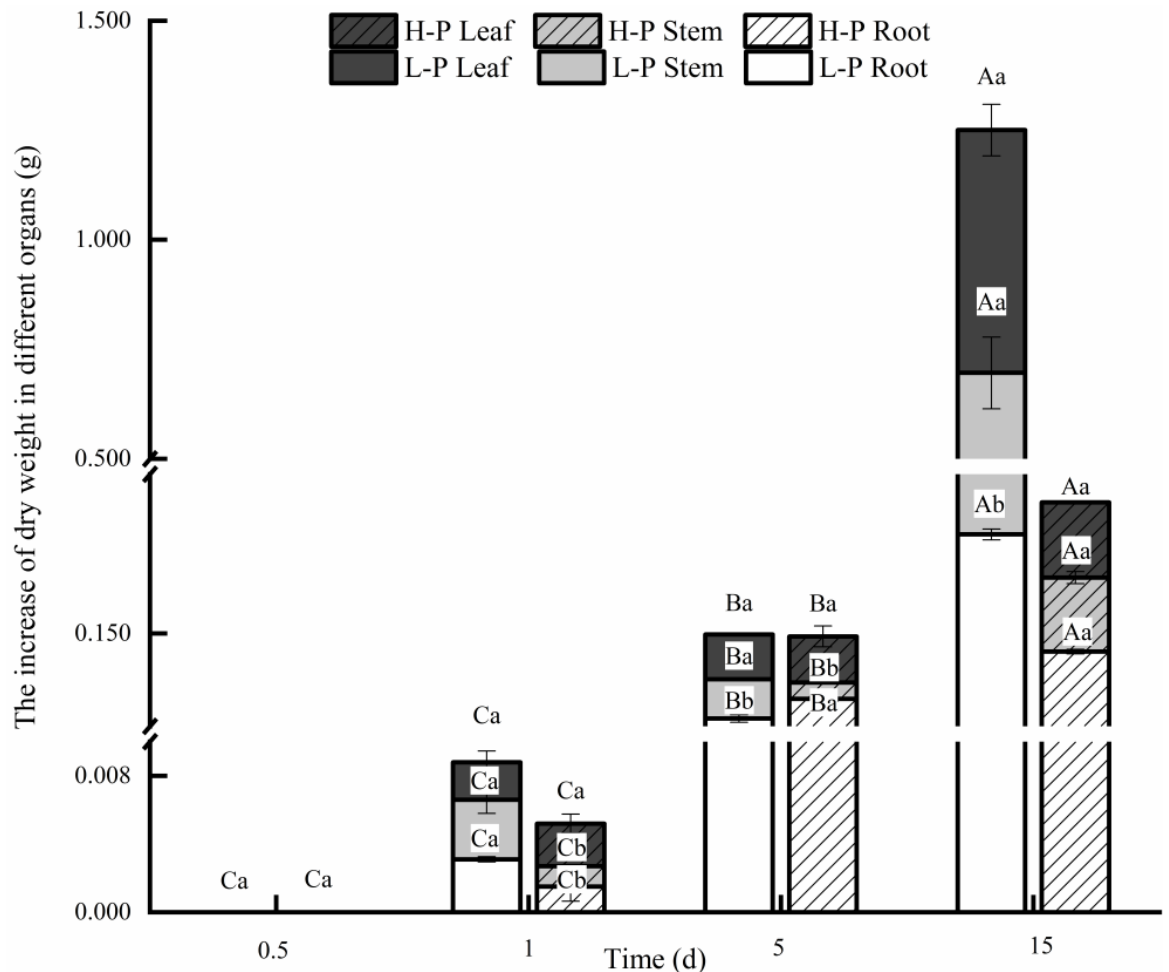
Figure 1. The increase in dry weight in different organs at different treatment times under different P supply conditions. “L-P” and “H-P” represent the low-P and high-P treatments, respectively. Error bars represent standard error, and each point in the figures represents the mean of five replicates ( n = 5). Lowercase letters indicate significant differences ( p < 0.05) at different treatment times under the same P treatment. Uppercase letters indicate significant differences ( p < 0.05) between different treatments at each time point. Labeling conventions are the same across time points.